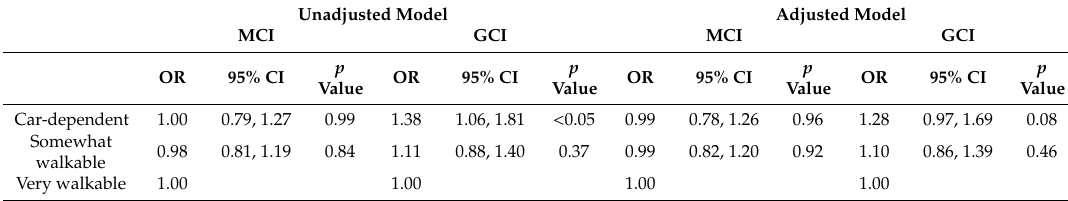
Table 2. Multinomial logistic regression analysis with cognitive status as the dependent variable. Unadjusted Model Adjusted Model